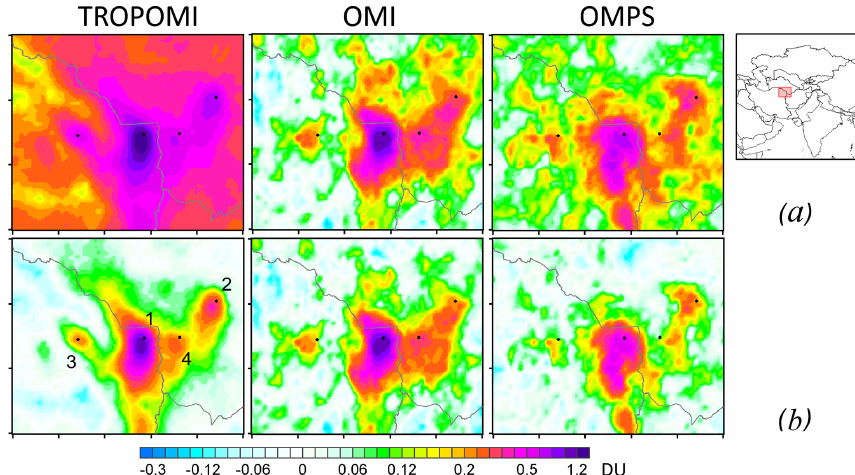
Figure 11. TROPOMI, OMI and OMPS mean SO 2 (DU) over the Khangiran region for the period from April 2018 to March 2019 (a) . The same data, but with large-scale biases removed (b) . Data are smoothed by oversampling/pixels averaging with R = 20km. The black dots indicate the SO 2 emissions sources: gas refinery at Khangiran, Iran (1); gas exploration sources at Mary (2) and Sovetabad (4), Turkmenistan; Toos and Ferdosi power plants, Iran